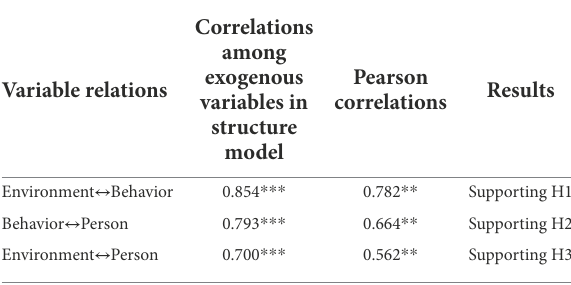
TABLE 4 The correlation hypothesis verification of the three dimensions of reciprocal